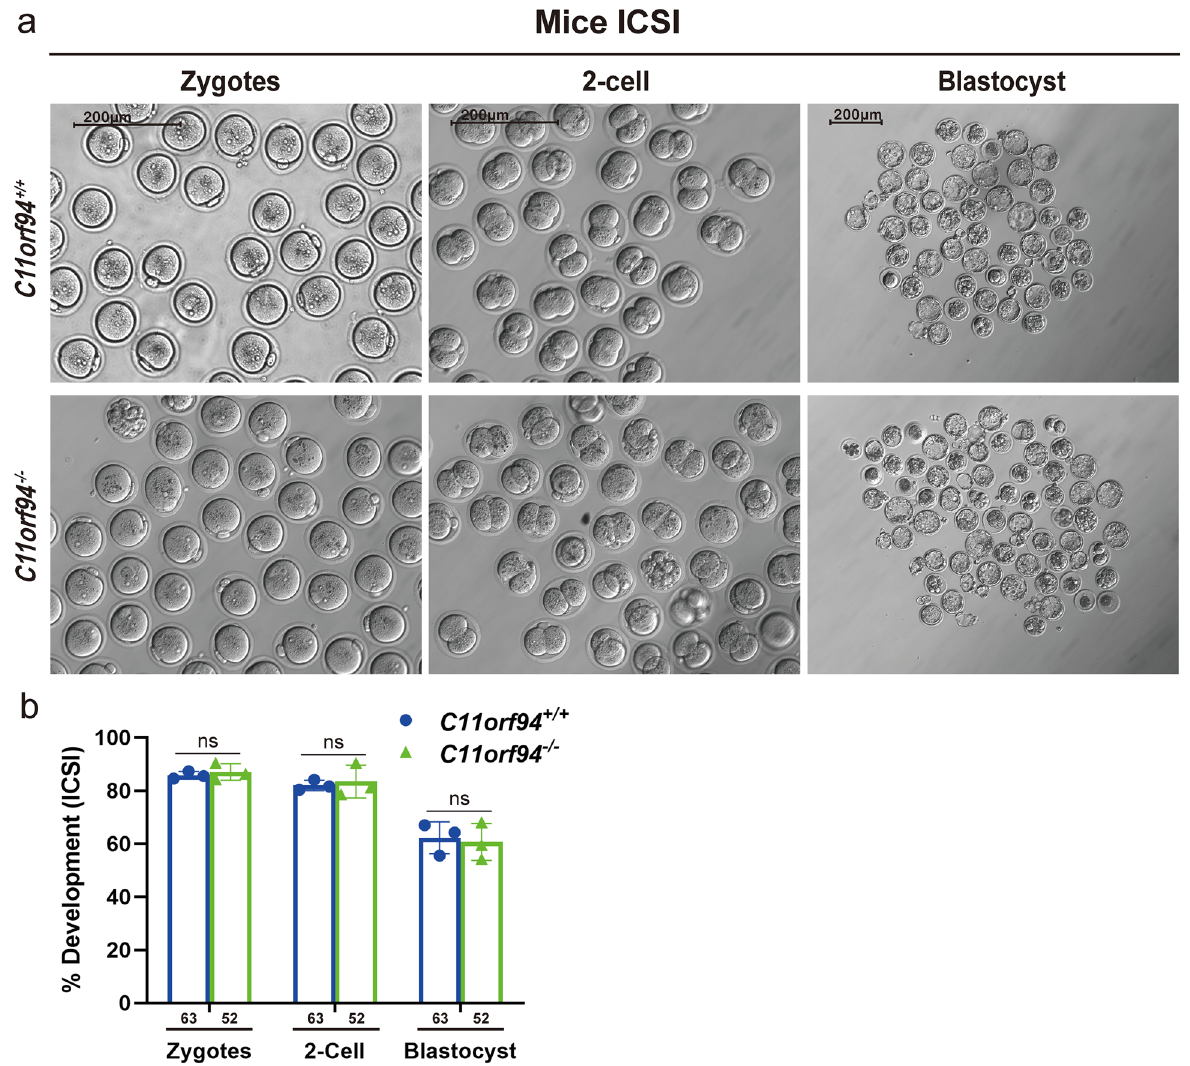
Fig. 7 ICSI rescues the fertilizing ability of C11ORF94-deficient sperm. The C11orf94 + / + and C11orf94 − / − males mice survival rate of fertilized oocytes and representative diagram of fertilized oocytes at pronucleus stage, 2-cell and blastocyst developmental stages after ICSI. Scale